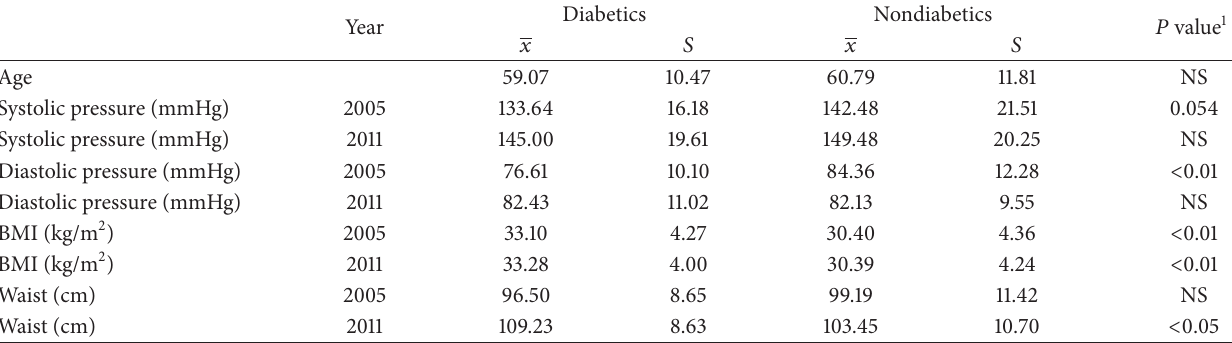
Table 3: Comparison between diabetics and nondiabetics according to clinical antecedents.